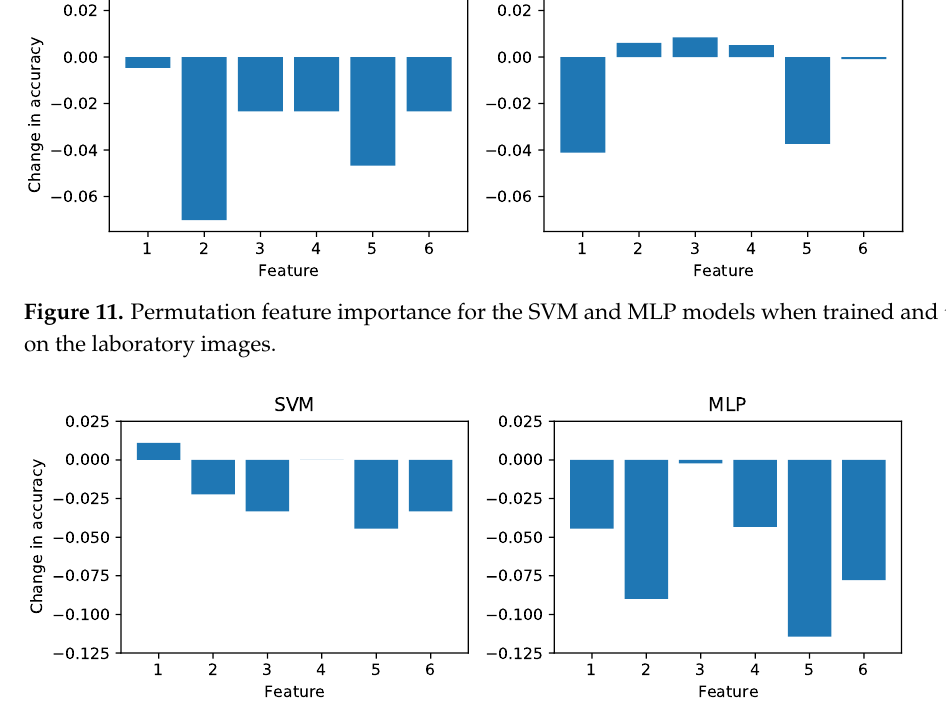
Figure 12. Permutation feature importance for the SVM and MLP models when trained and tested on the real-world